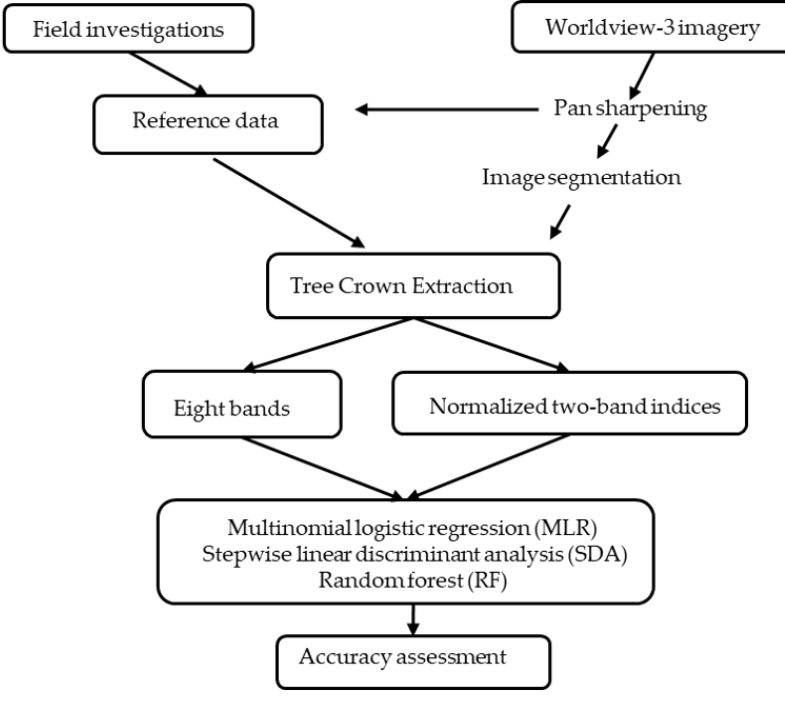
Figure 4. Flowchart of shoot damage classification approach.